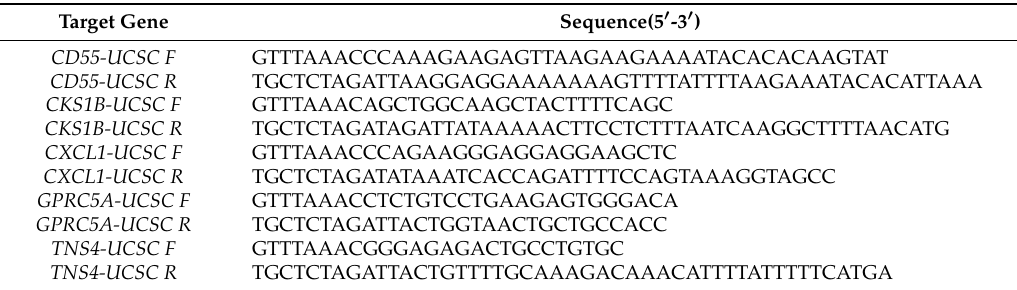
Table 5. Primers for 3 (cid:48) UTR